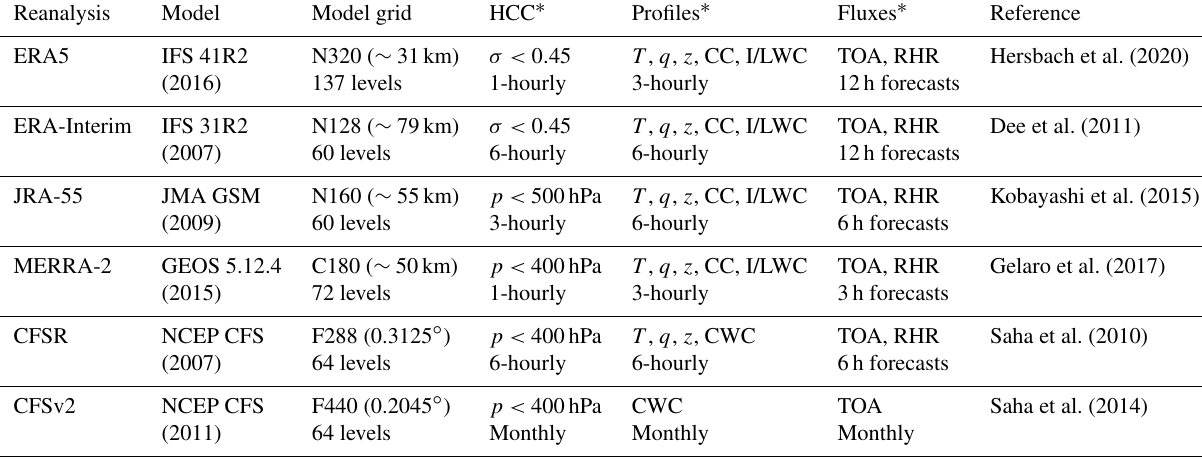
Table 1. Summary of reanalysis products. HCC stands for high-cloud fraction; CC stands for cloud fraction; CWC stands for cloud water content; I/LWC stands for separate ice and liquid water contents; TOA stands for top-of-atmosphere fluxes (short-wave and long-wave and clear-sky and all-sky); and RHR stands for radiative heating rates (short-wave and long-wave and all-sky). We use CFSR products for 1980–2010, CFSv2 for 2011–2014, and all other reanalysis products for 1980–2014. IFS: Integrated Forecast System. JMA GSM: Japan Meteorological Administration Global Spectral Model. NCEP CFS: National Centers for Environmental Prediction Climate Forecast